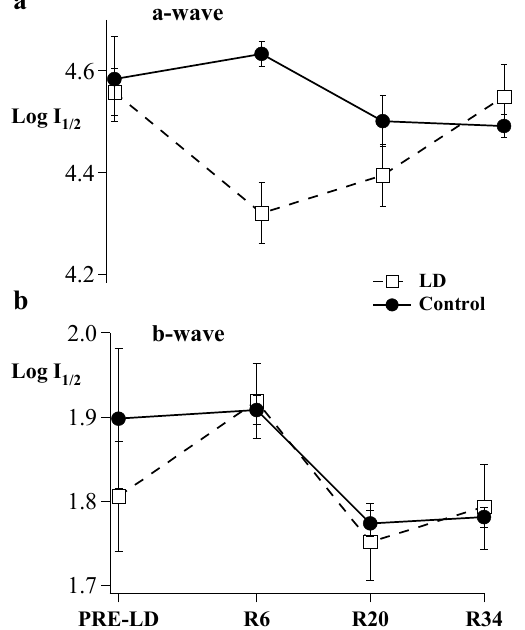
Figure 3. An intensity response (IR) series was recorded by progressively increasing flash intensity. Resulting curves were fit by a modified Michaelis function. Sensitivity (Log I 1/2 ) for ( a ) a ‐ and ( b ) b ‐ waves were calculated before light damage and on R6, R20, and R34. Open squares connected by dashed lines show results for light ‐ damaged animals ( n = 6 to 10). Filled circles connected by solid lines show results for control animals ( n = 3 to 6), Error Bars = ± SEM.